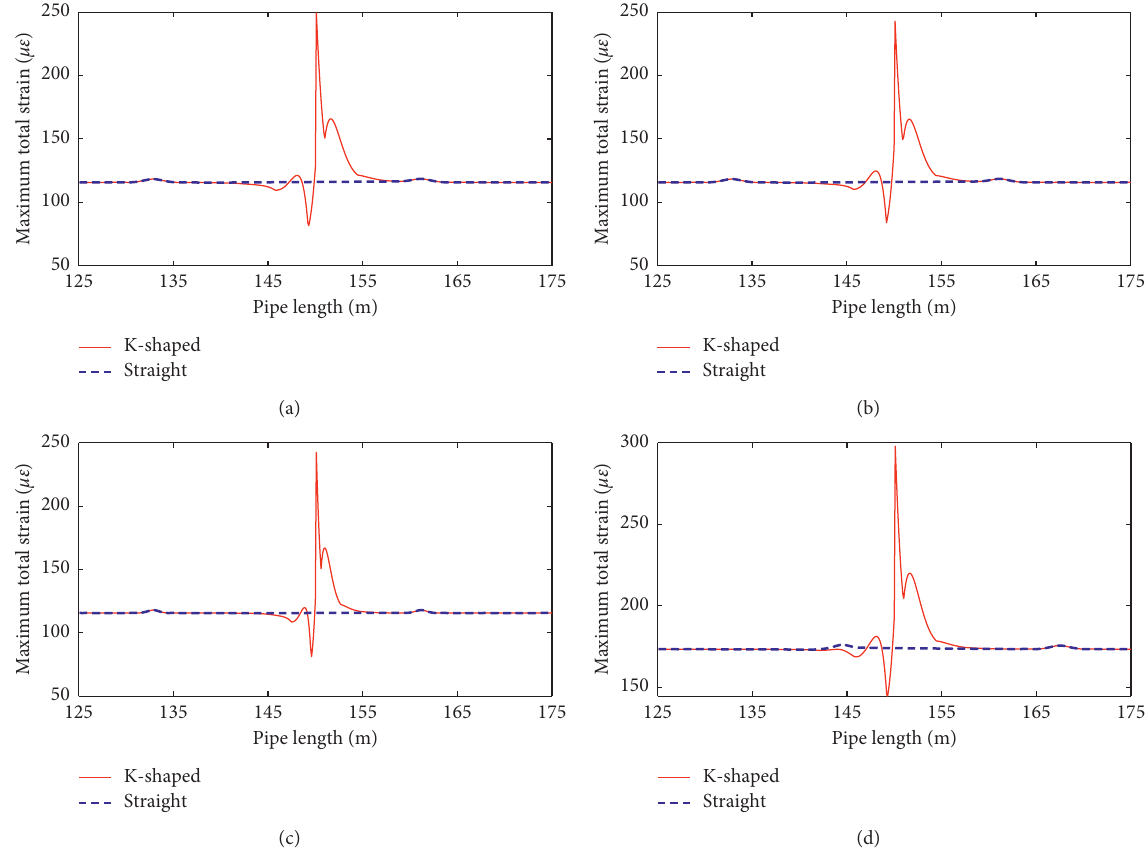
Figure 24: Maximum strain of K-shaped connection under different parameters: (a) Case K-1, II-site; (b) Case K-2, 30 ° branch angle; (c) Case K-3, 0.2191m pipe diameter; (d) Case K-4, 30 ° incident angle.